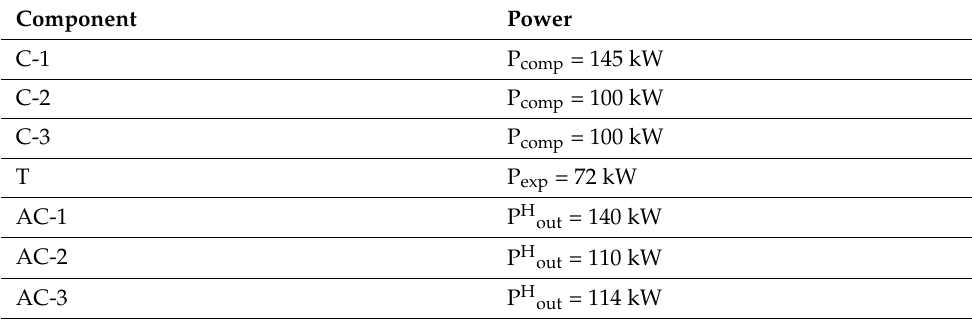
Table A2. This power data refer to operating unit in Base Case.